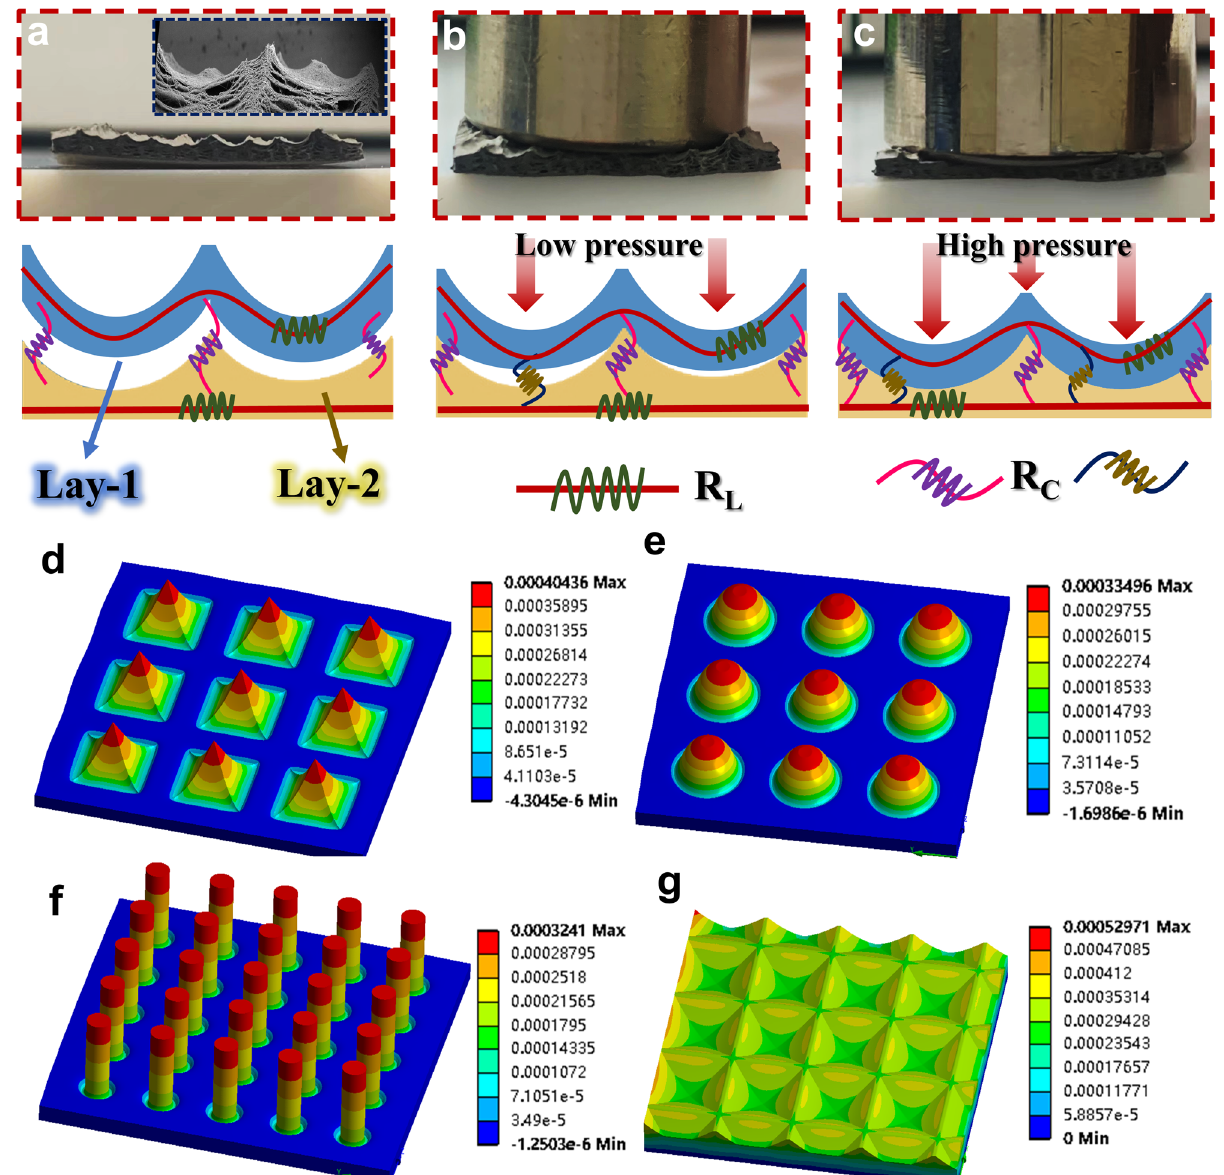
Fig. 4 Working mechanism and pressure simulation of TPPCN pressure sensor. a – c Photographs and schematic illustrations of equivalent circuit models corresponding to initial, low-pressure, and high-pressure states. d – g The simulation results of pressure distribution for different surfaces: pyramid, hemisphere, cylinder, and grid-like morphology at an external loading pressure of 5